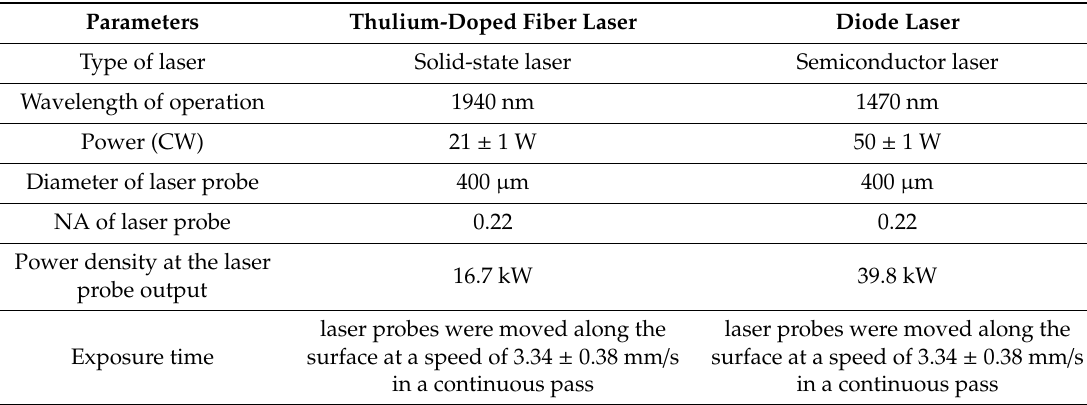
Table 1. Parameters of the lasers used during the